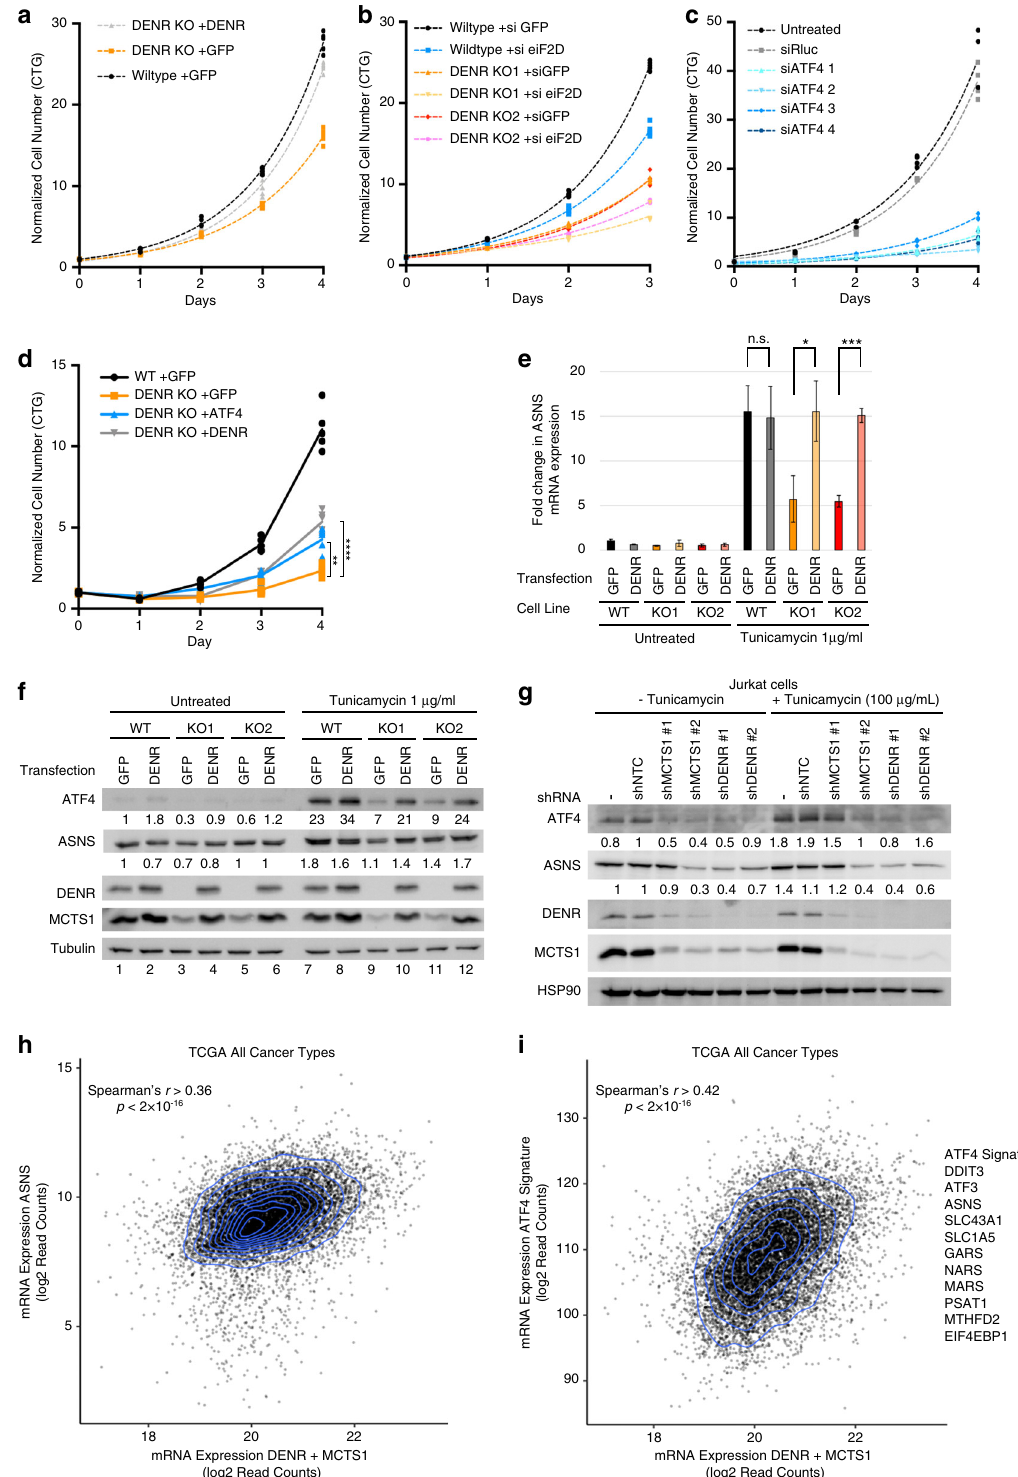
AGCACCAA), two shRNA constructs targeting DENR (shDENR #1: GATGA TGACAGCATCGAAGAT; shDENR #2: GAATTAGTGAGGGTCAAGGAA) and two shRNA constructs targeting MCTS1 (shMCTS1 #1: CCCTAAGATTAC TTCACAAAT; shMCTS1# 2: TGTACTCAGTGGAGCAAATAT). 293T cells were seeded in 10-cm dishes and co-transfected with these plasmids, together with pMD2.G and psPAX2 using Trans IT transfection reagent (MirusBio, MIR 2300). Lentiviruses were harvested 72 h post-transfection and fi ltered through a 0.45µm PVDF sterile syringe fi lter (Carl Roth GmbH, P667.1). For Jurkat cells, 50,000 cells were supplemented with 5µg/ul of polybrene (Merck Millipore, RT-1003-G) and